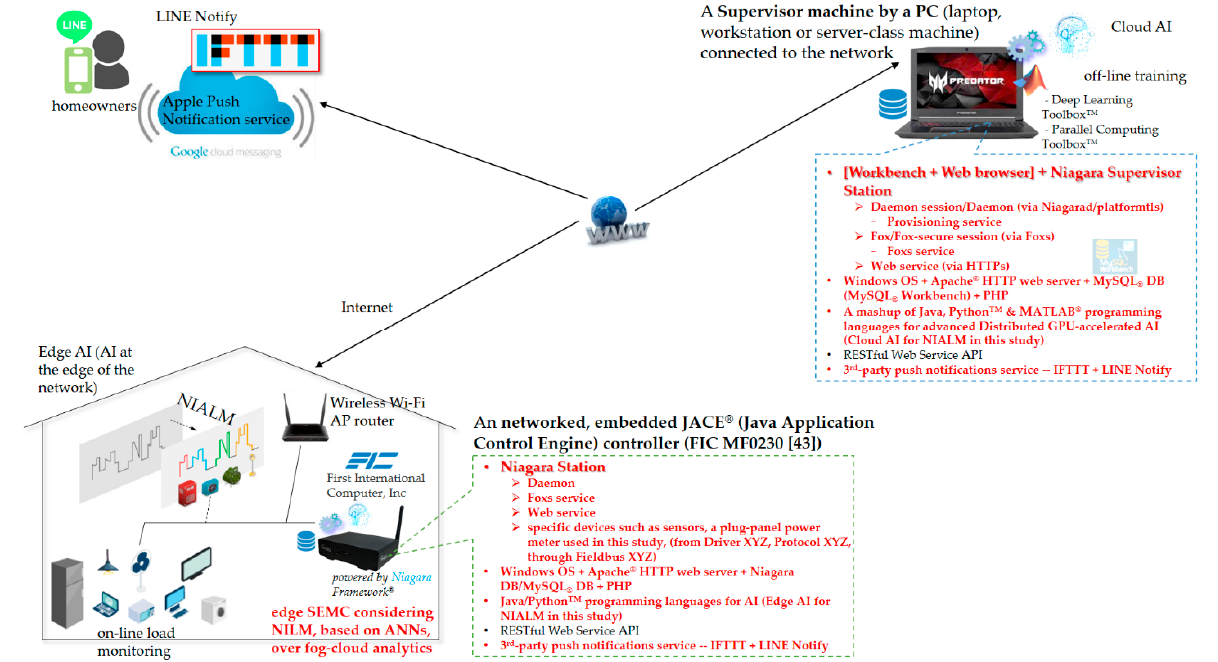
Figure 3. Developed smart home energy management system (SHEMS) prototype considering new two-stage NIALM over fog-cloud computing in this study, where the prototype is based on Tridium’s Niagara Framework ® . The framework runtime is targeted for Java 8 SE compact3 profile compliant virtual machines (VMs). MATLAB ® is suited and used as the cloud here.